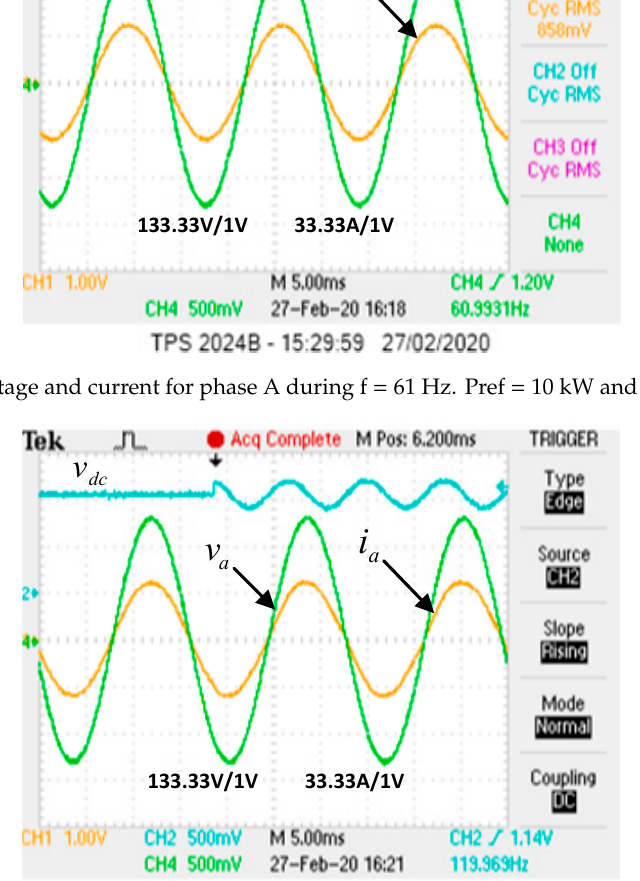
Figure 21. Voltage and current for phase A during V dc = 380 V + 38 V at 120 Hz. Pref = 10 kW and Qref = 0.